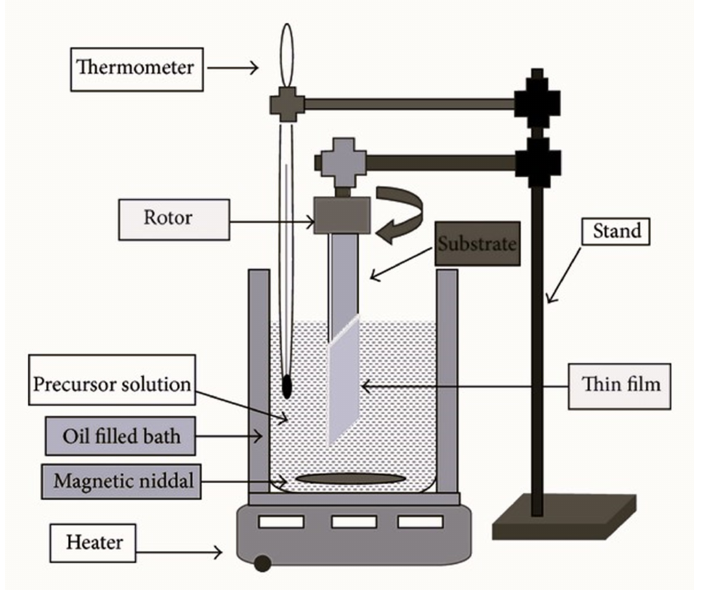
Figure 8. Overview of the setup for the chemical bath deposition method. Reproduced with permis- sion from [60].